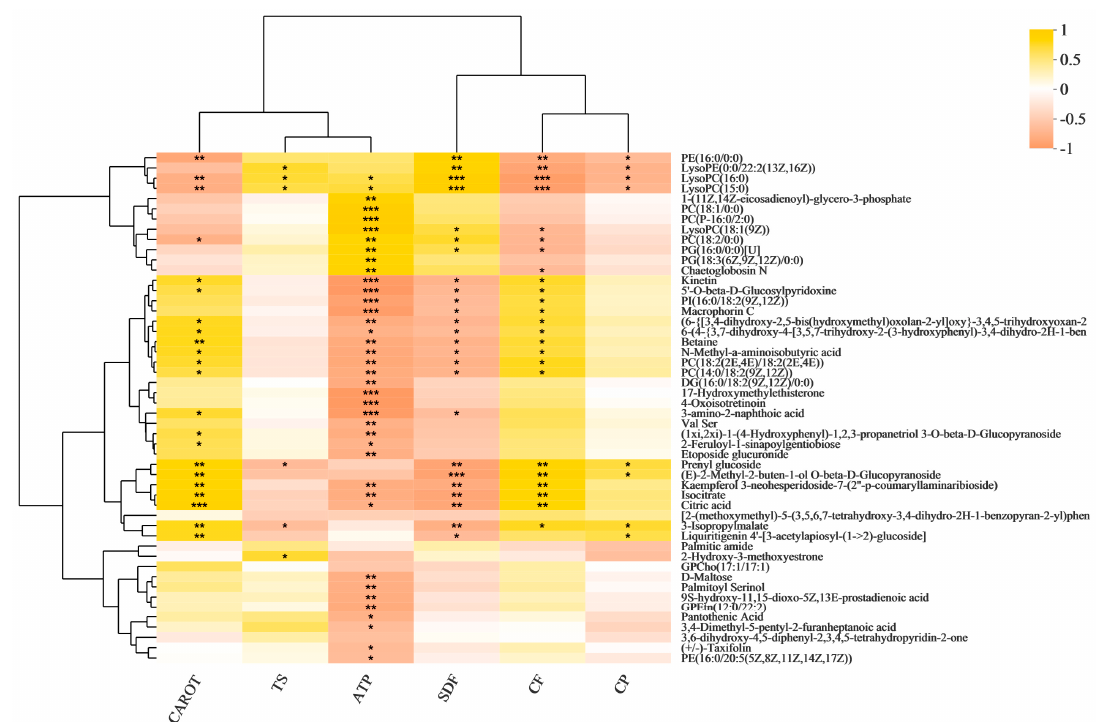
Figure 2. Correlation analysis of the major nutrients with DMs. * p < 0.05; ** p < 0.01; *** p <